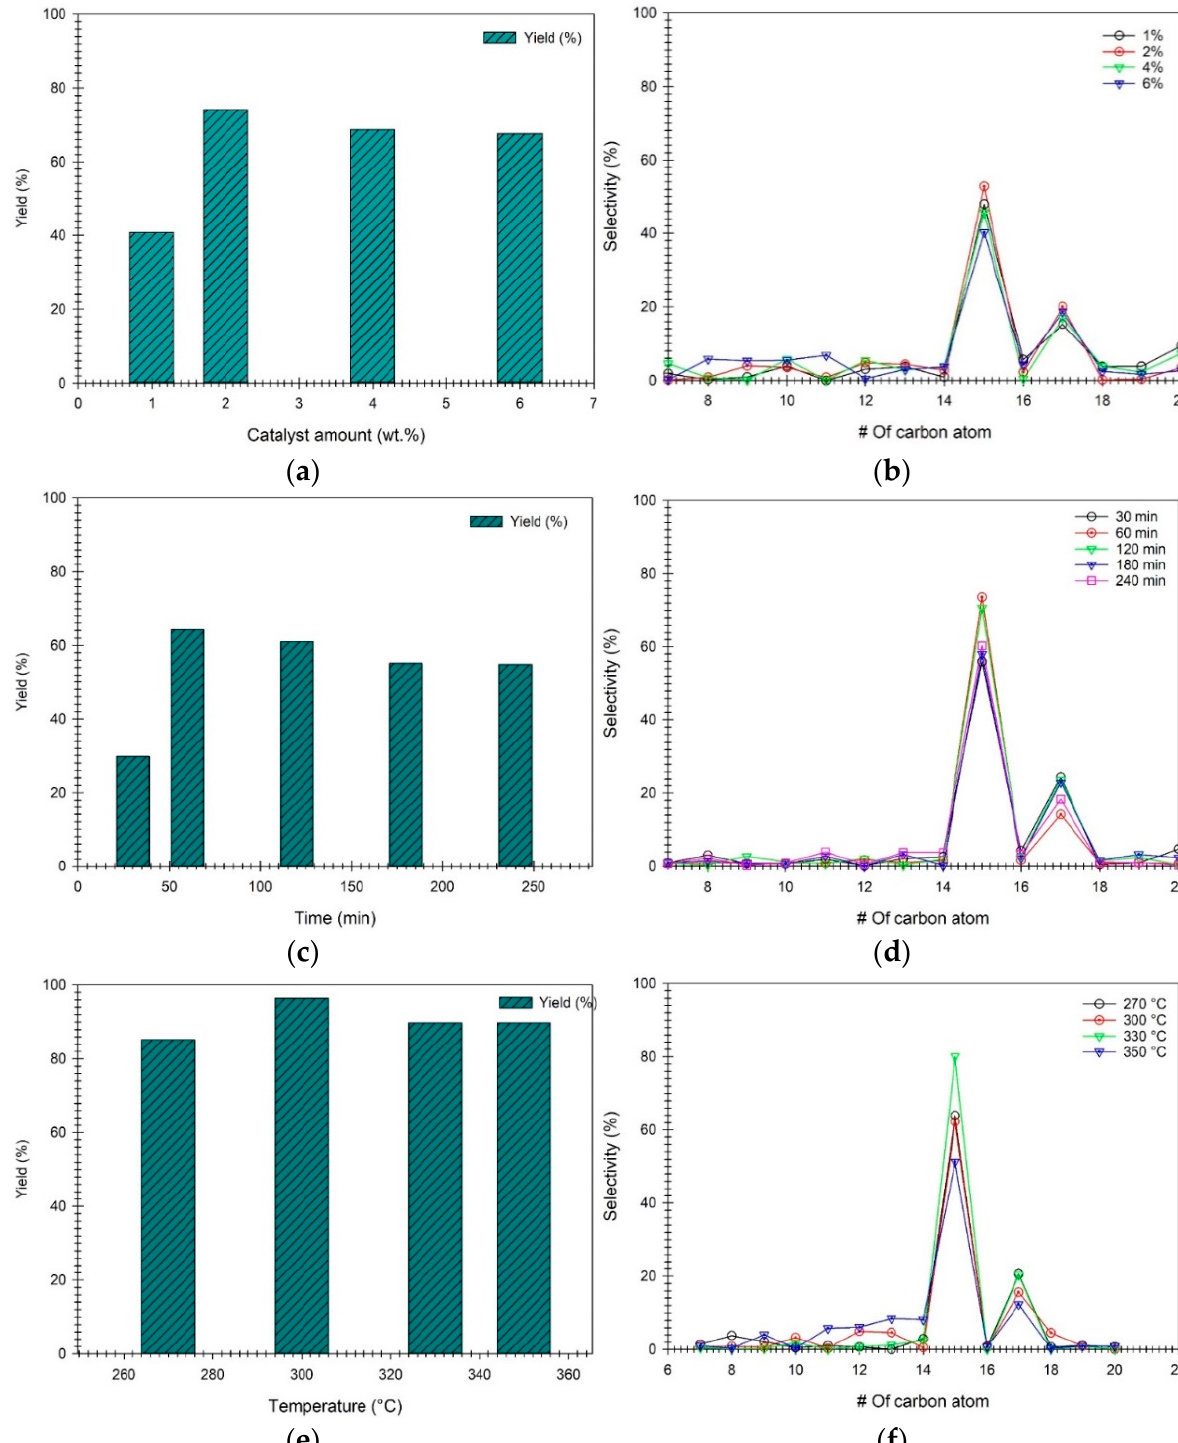
Figure 6. Reaction optimization condition of Mn (0.5%) -Mo (0.5%) /AC. ( a , b ) Effect of catalyst loading, ( c , d ) effect of reaction time and ( e , f ) effect of reaction temperature.